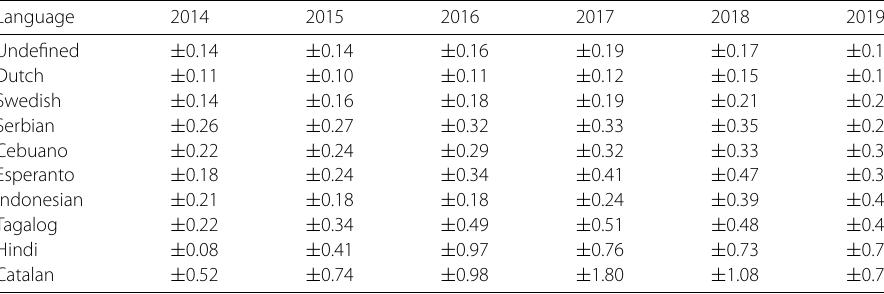
Table 4 Top 10 languages with the highest average margin of error for estimating contagion ratios as a function of the agreement between FastText-LID and Twitter-LID (sorted by 2019)